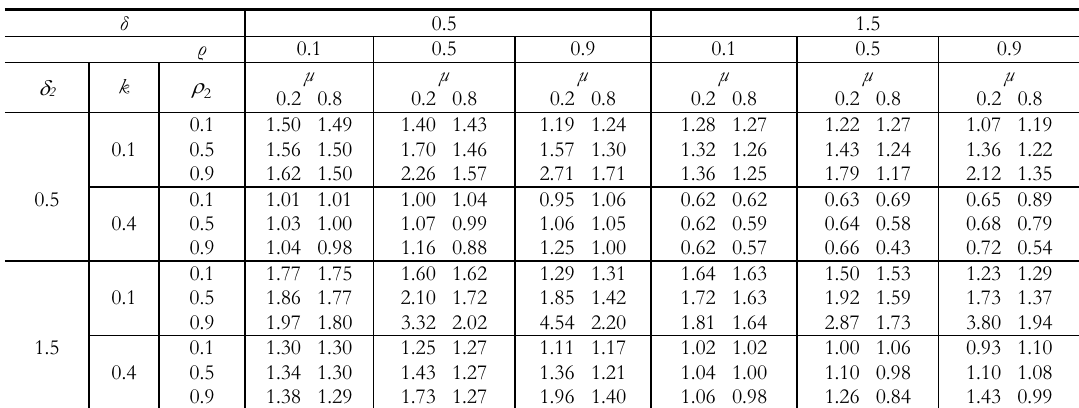
with respect to T 2